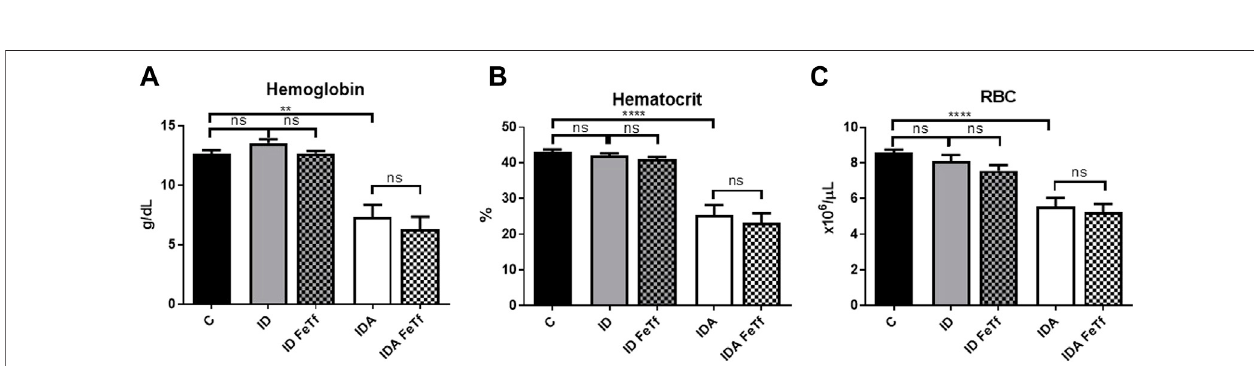
FIGURE 4 | Acute holotransferrin administration does not alter the erythroid phenotypes found in the murine models of ID and IDA. ID and IDA mice were treated with carrier or holotransferrin. (A) Hemoglobin, (B) hematocrit and (C) red blood cell counts were measured. Control mice fed a standard 250 ppm Fe diet are included for reference. For control mice n = 16, for ID cohorts n = 6 – 11 and for IDA cohorts n = 6-7 mice per group. ppm, parts per million; Data represented as mean (SEM) *, p < 0.05; ***, p < 0.005; ****, p < 0.001; ns, non-signi fi cant.